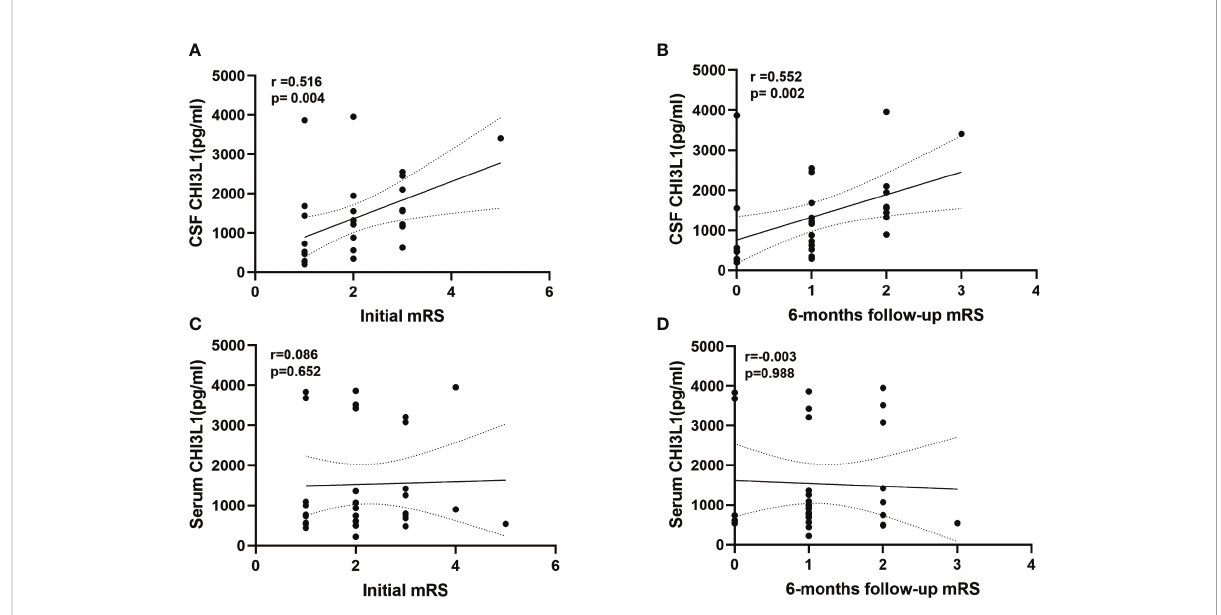
FIGURE 3 Levels of CHI3L1in cerebrospinal fl uid (CSF) and serum association with modi fi ed Rankin Scale (mRS) at admissiom and 6 months follow-up. (A, B) Correlation between CSF CHI3L1 levels andmRS at admissiom and 6 months follow-up in anti-LGI1 encephalitis patients. (C, D) Correlation between serum CHI3L1 levels andmRS at admissiom and 6 months follow-up in anti-LGI1 encephalitis